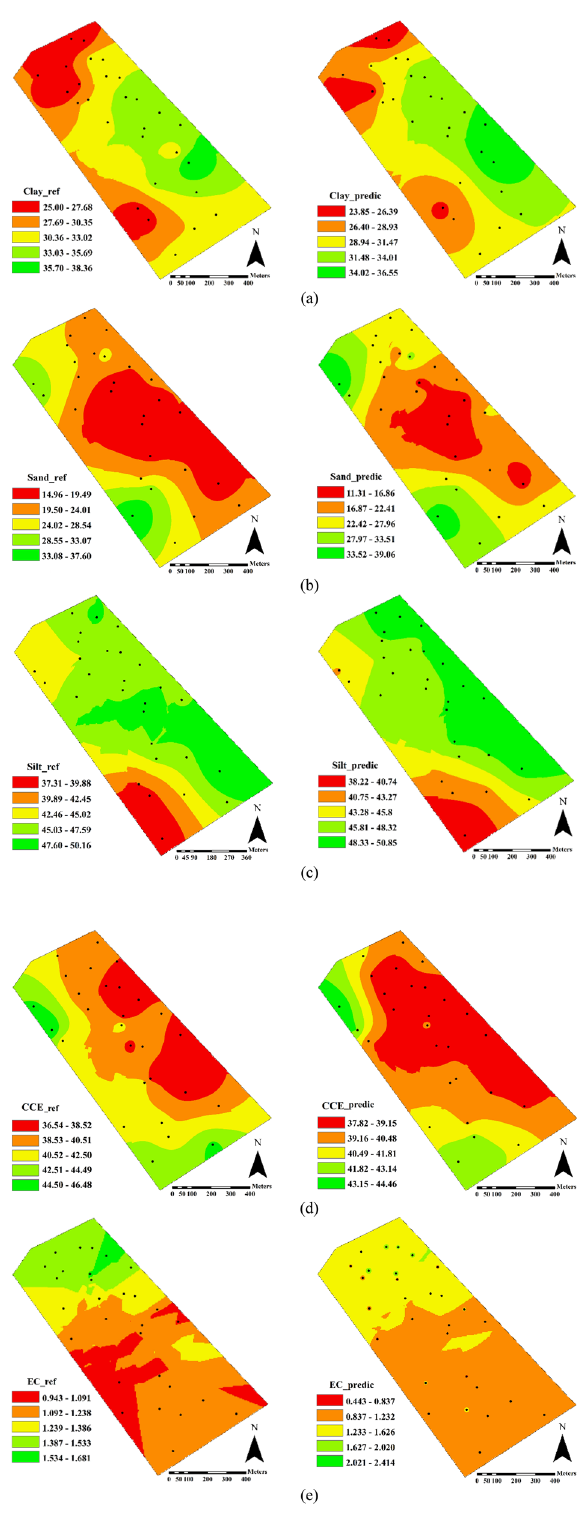
Figure 7. Field-scale spatial variation maps of reference and estimated values of ( a ) clay, ( b ) sand, ( c ) silt, ( d ) calcium carbonate equivalent (CCE), and ( e ) electrical conductivity (EC), obtained from best predictive models in the CCD spectral range (400–1100